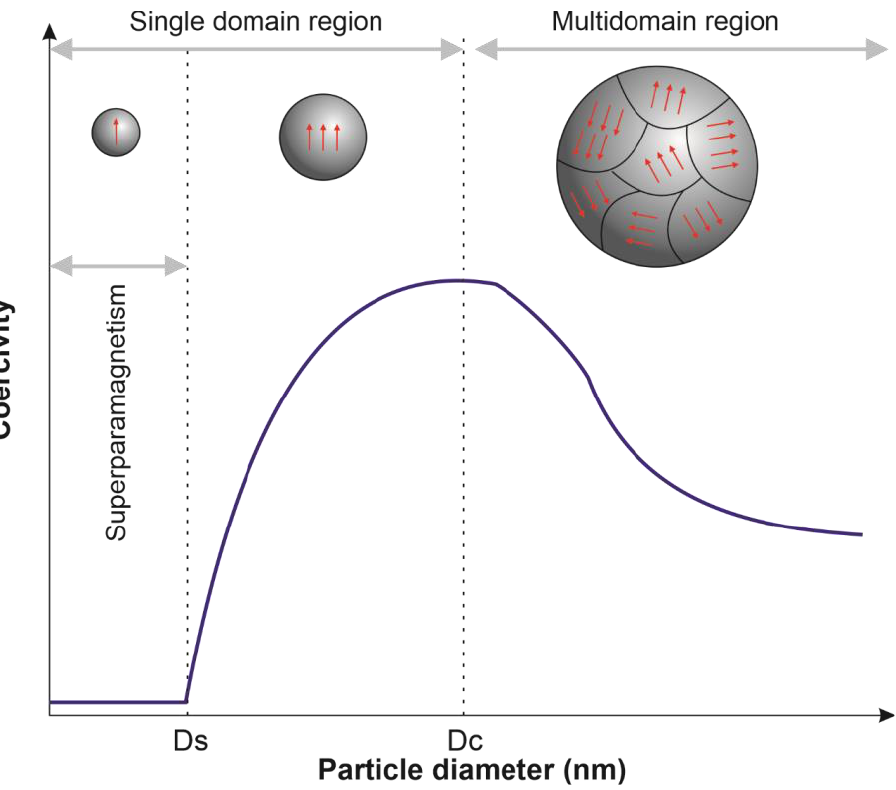
Figure 1. Illustration of the magnetic nanoparticles transition from superparamagnetic to multidomain region according to particle diameter. The red arrows illustrate the orientation of the domains.